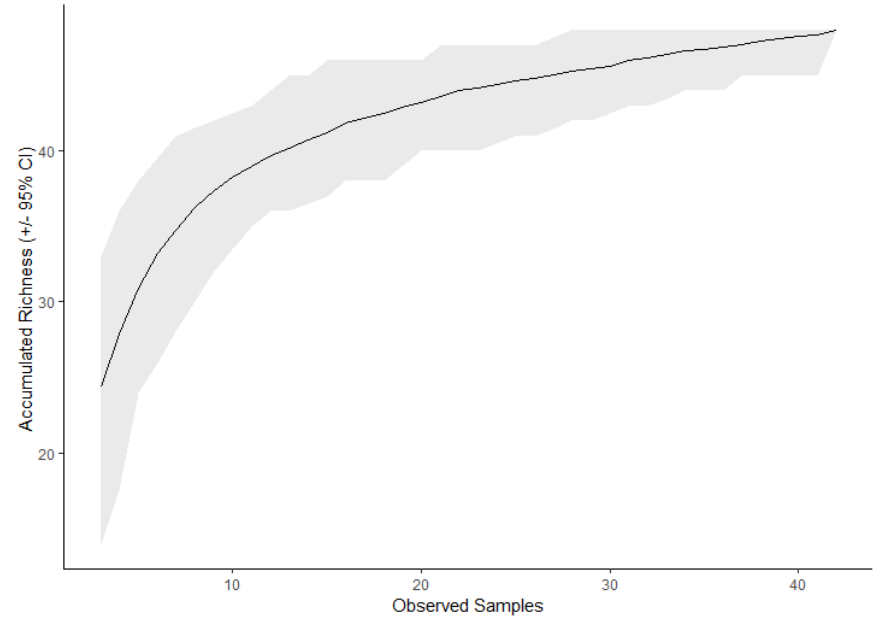
Figure A2. Species accumulation curve (±95% CI) derived from the observed samples analysed in the experiment. Table A1. Observed and expected maximum number of taxa calculated using four separate resampling methods. Method Expected # of Taxa ±95% C.I.